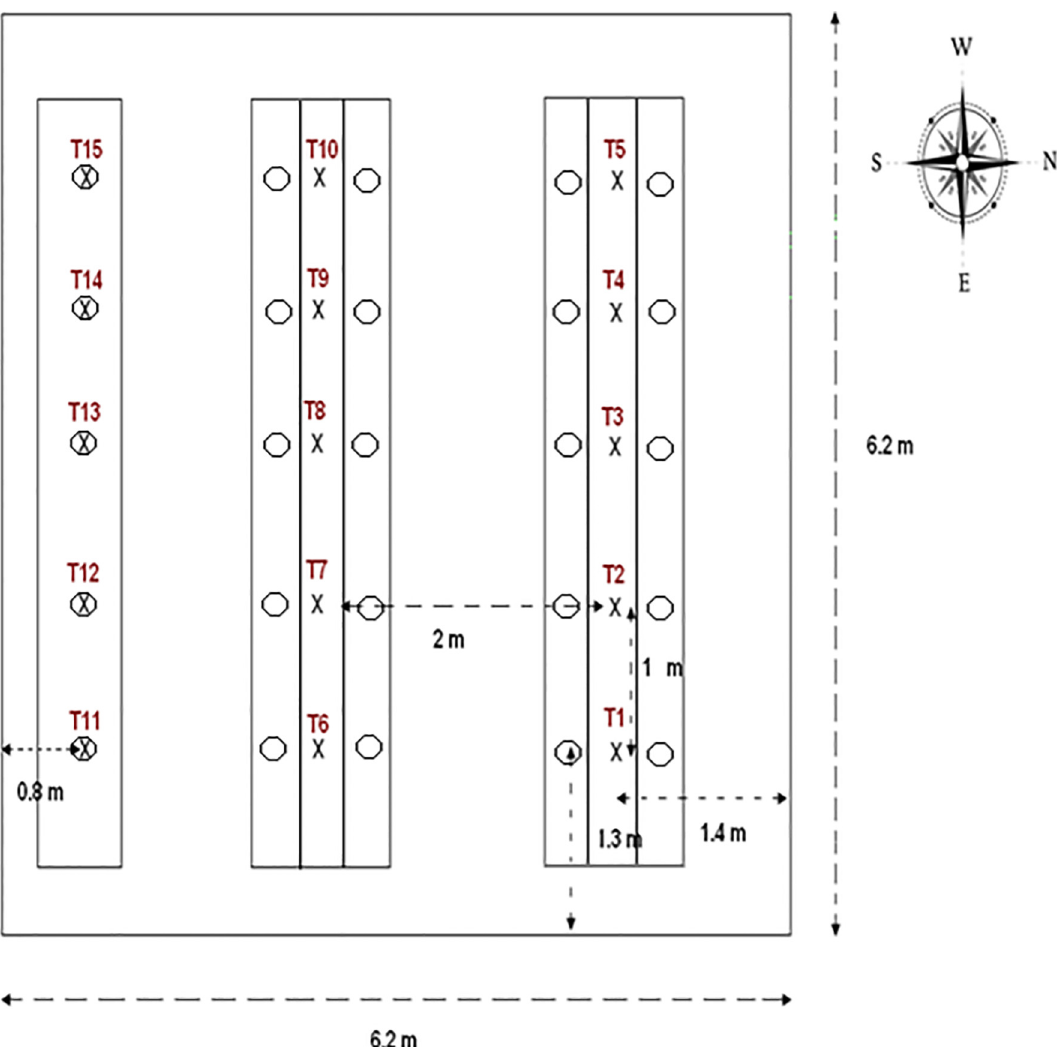
Fig 1. Layout of temperature and humidity sensors (x) and sampled plants (o) locations inside the experimental